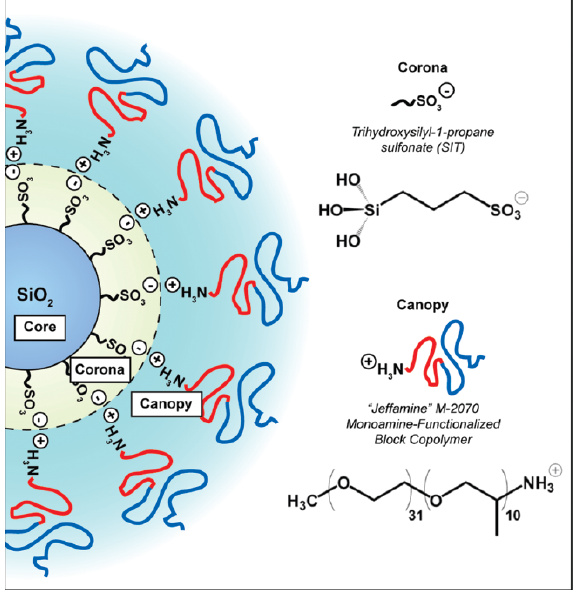
Figure 2. Schematic of the general structure for nanoscale ionic materials (NIMs) used in this study. The covalently attached corona has terminal sulfonic acid functionality. The canopy consists of a low molecular weight, amine-terminated diblock copolymer. Reprinted with permission from Jespersen et al. [35].